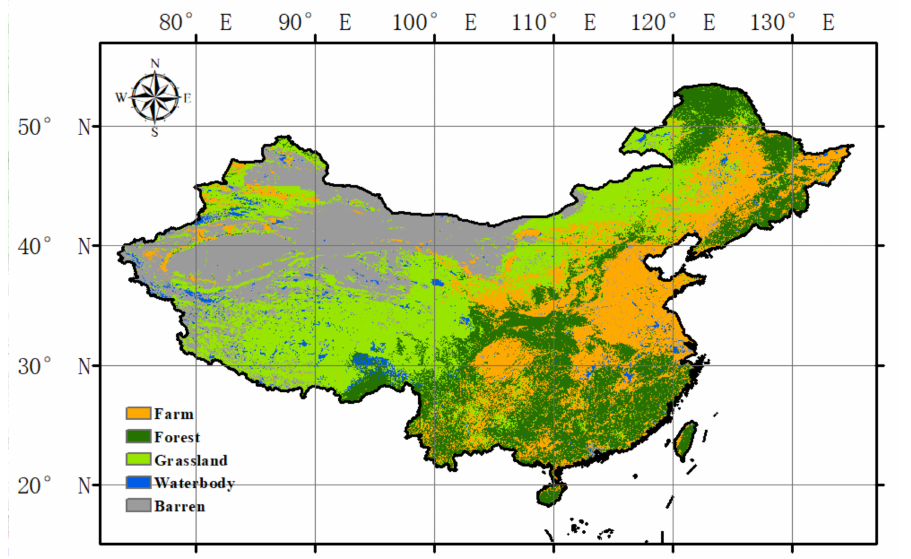
Figure 5. Globeland30 land-cover map.